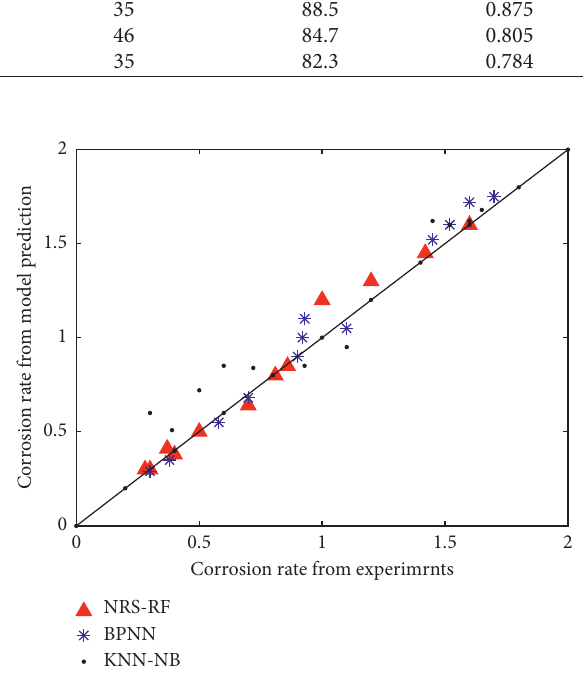
Figure 12: Correlation between the predicted value and actual